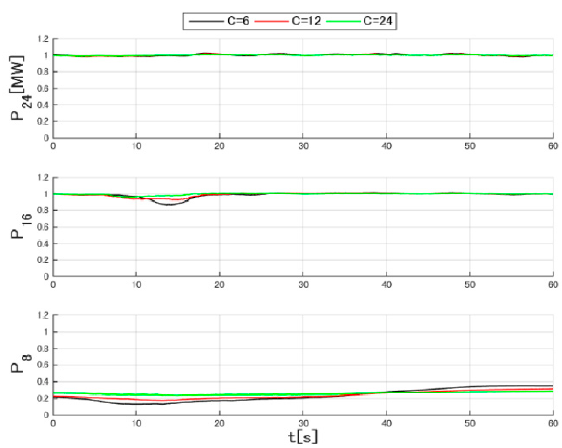
Figure 10. Example of the time history of the total power to the coherence decay constant (24 m/s, 16 m/s and 8 m/s at the centre hub from top to bottom).